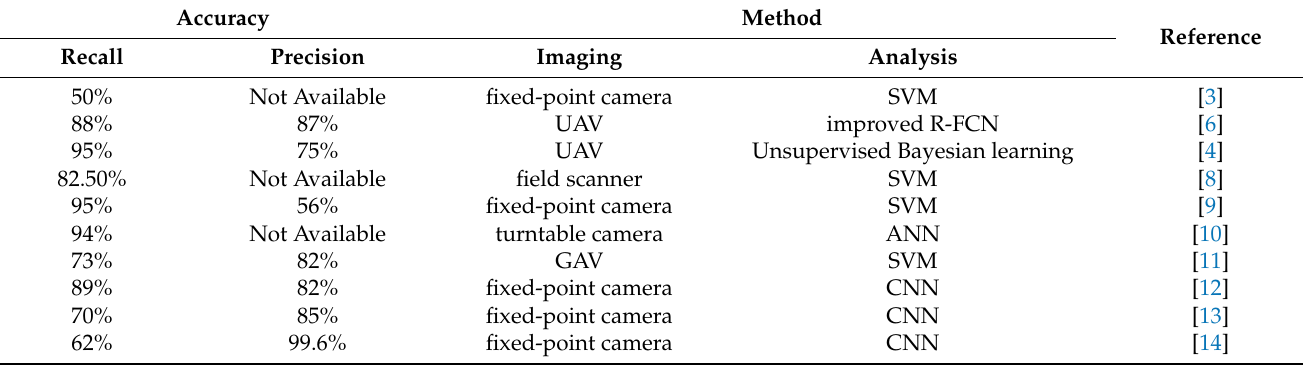
Table 1. Summary of various methods and their accuracy for panicle counting (not tiller counting).